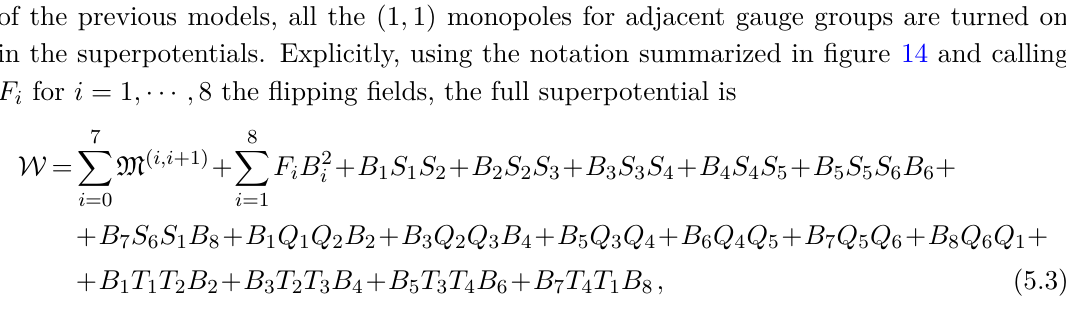
Figure 14 . The 3 d quiver representation of the torus with flux (2 avoid cluttering the drawing with too many intersecting lines, we depicted the quiver with the con- vention that SU(2) flavor nodes of the same color should be identified. We also explicitly label each chiral field with a name: B i for the SU(2) × SU(2) gauge bifundamentals, S j for the fundamentals of SU(2) 1 (in red), T j for the fundamentals of SU(2) 2 (in blue) and T a for the fundamentals of SU(2) 3 (in